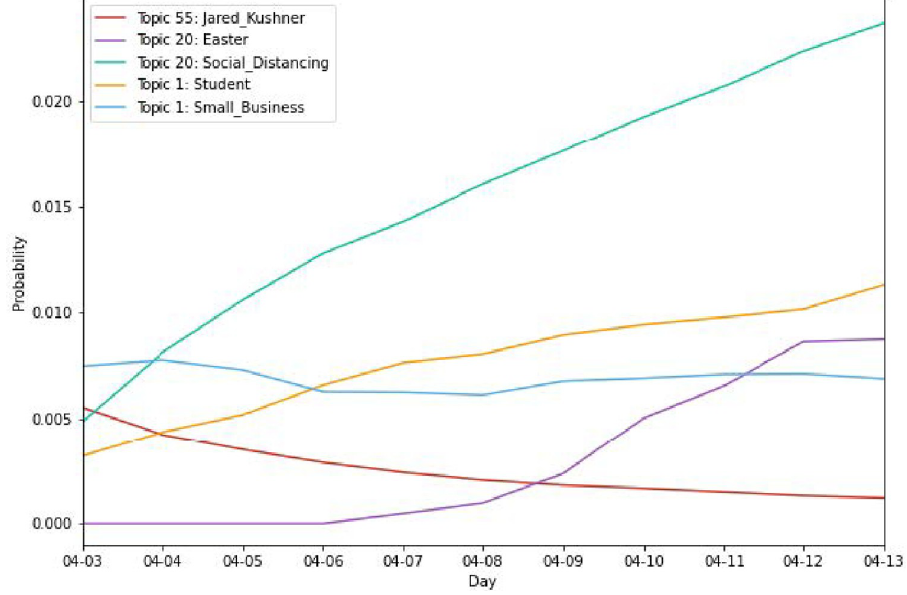
Fig 7. Changes in topic-word probabilities over